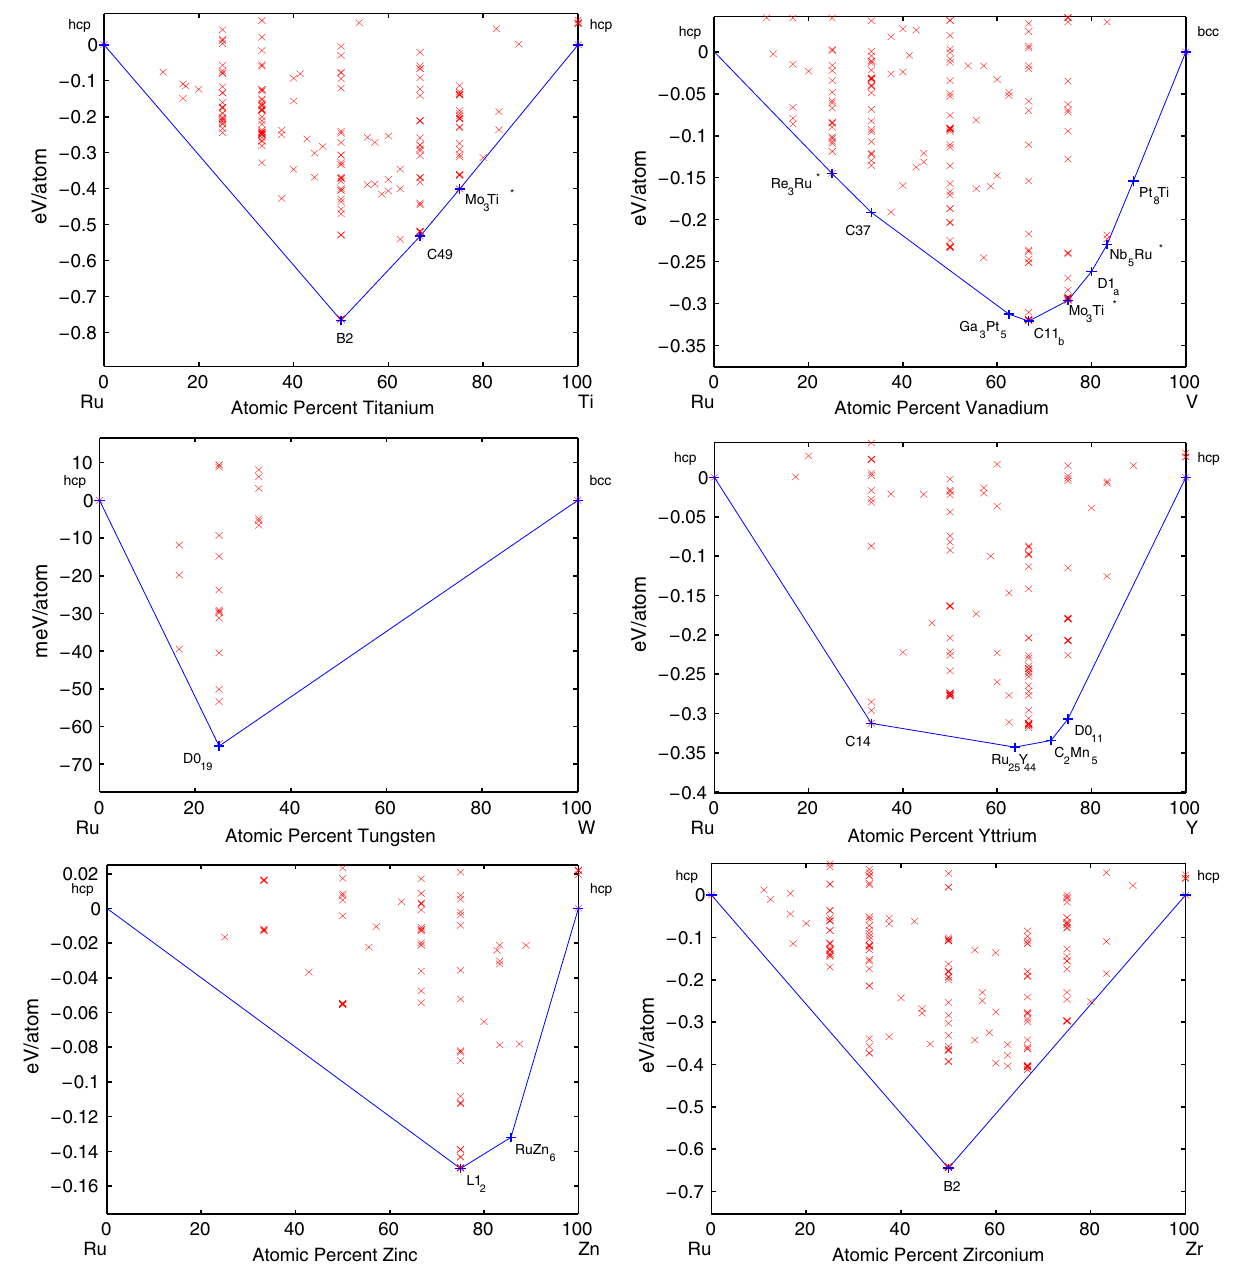
FIG. 19. Convex hulls for the systems Ru-Ti, Ru-V, Ru-W, Ru-Y, Ru-Zn, and